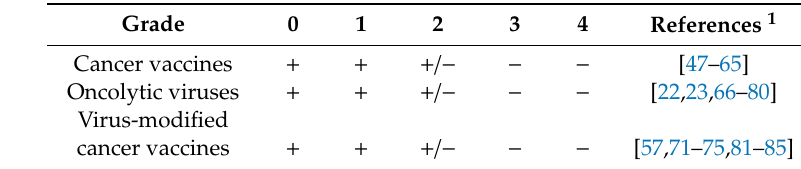
Table 5. Side e ff ects of cancer vaccines and of oncolytic